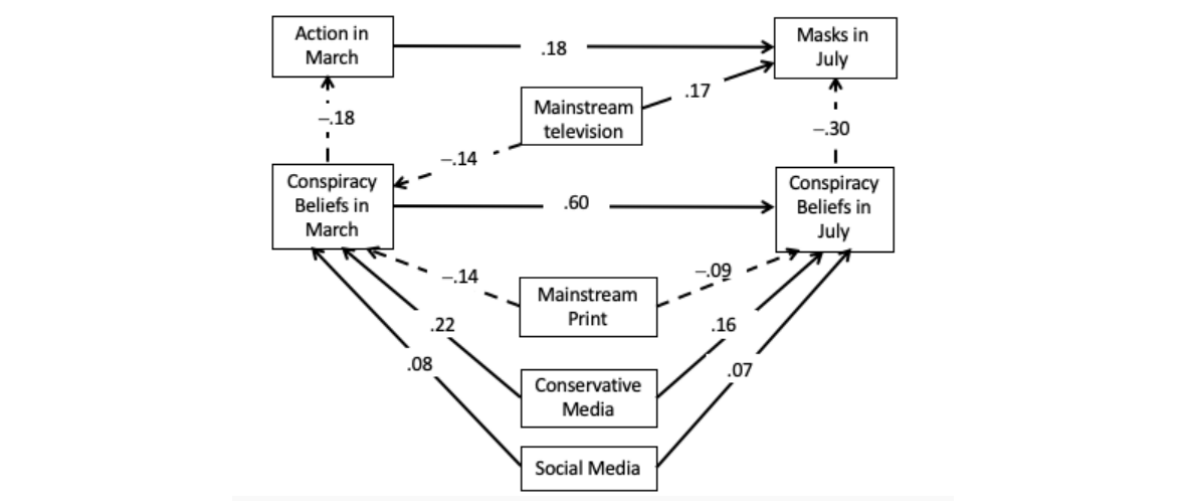
Figure 2. Standardized relations between media use in March and subsequent conspiracy beliefs and action taken to prevent spread of COVID infection in July. All paths within 99% CIs, except between social media and conspiracy beliefs in March, which excluded zero with a 95% CI.